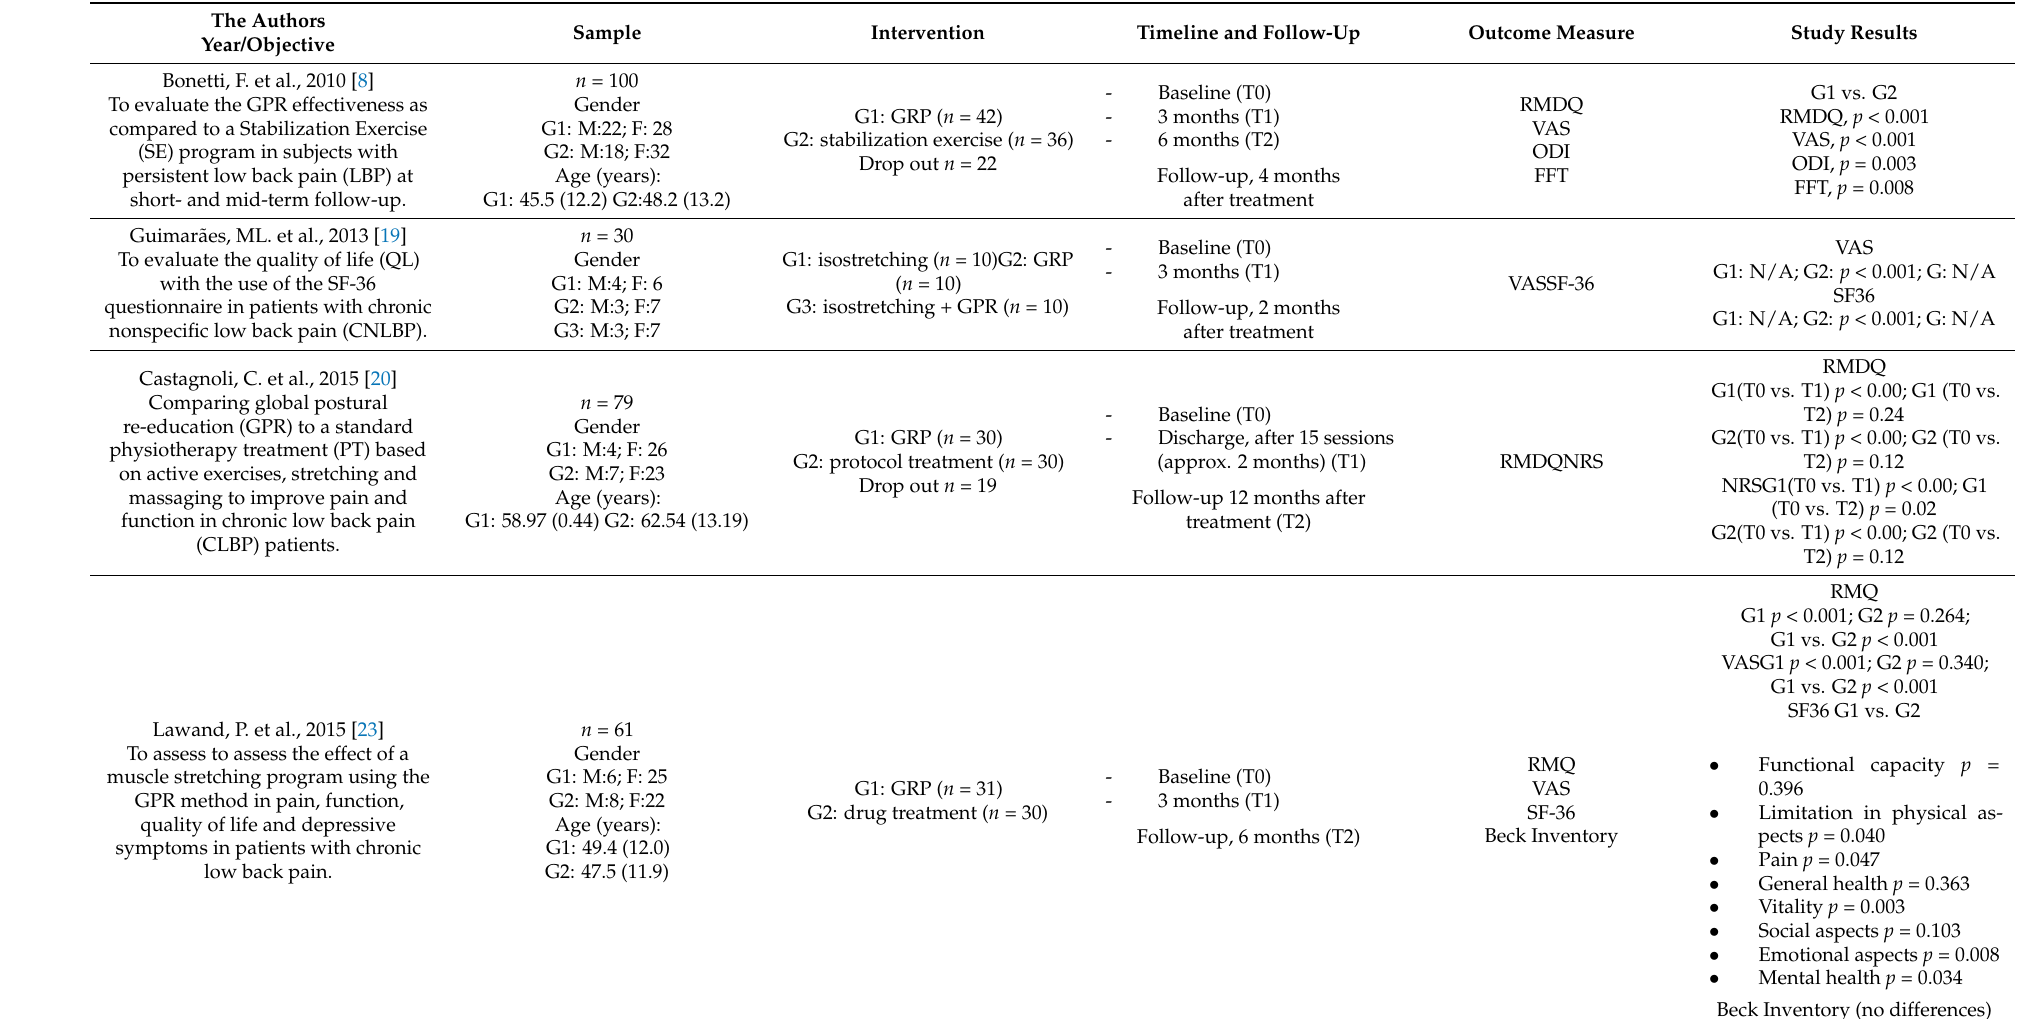
Table 1. Characteristics of the